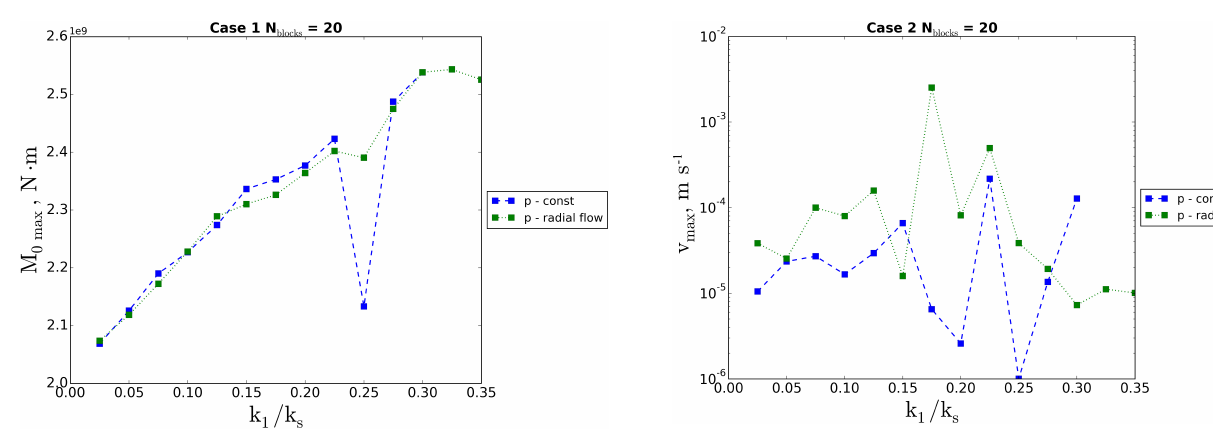
Figure 21. Maximum velocity dependence on the stiffness of the interblock link.